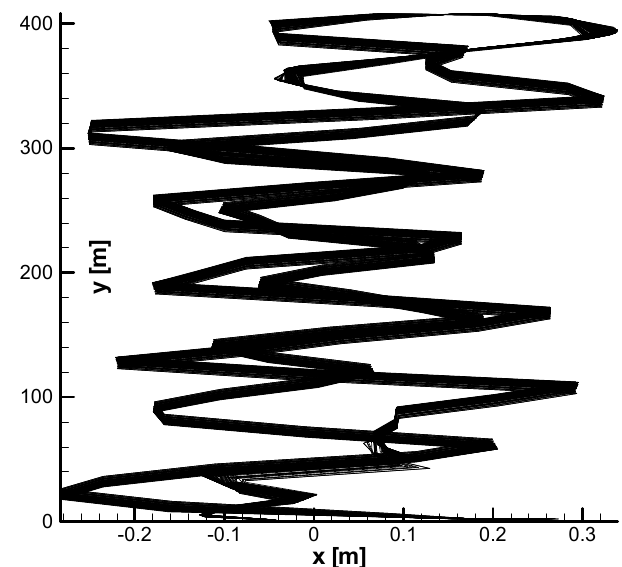
Figure 30. Trajectory beam in lateral view, case 1.